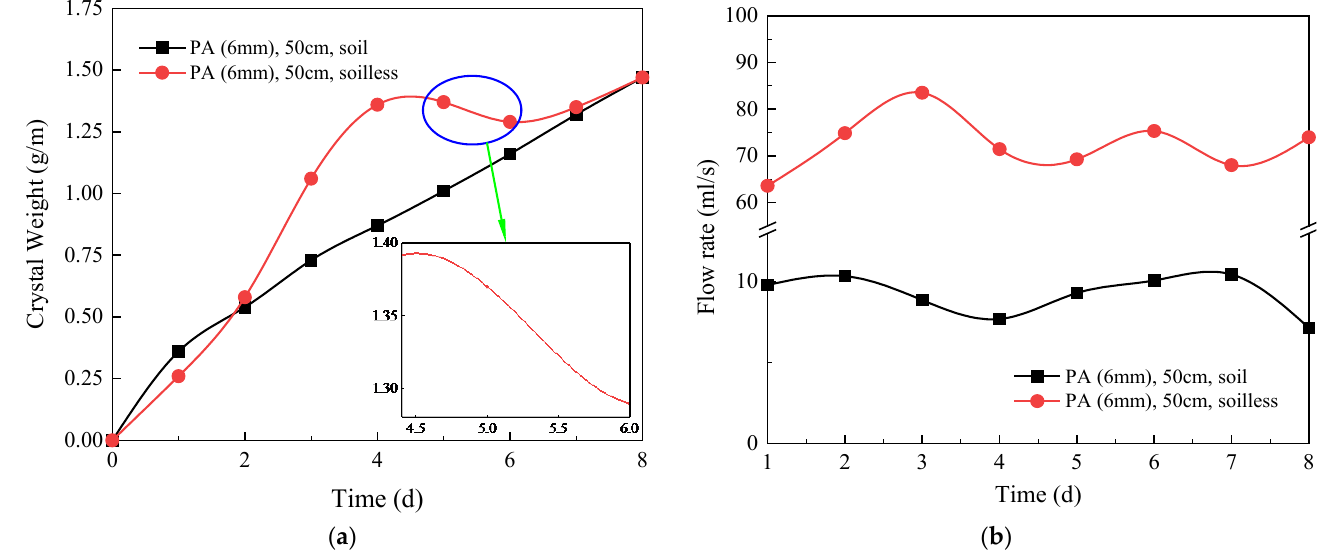
Figure 9. Variation of crystallization rate and flow rate of circular drainage pipes with time. ( a ) Crystallization rate curves. ( b ) Flow rate curves.